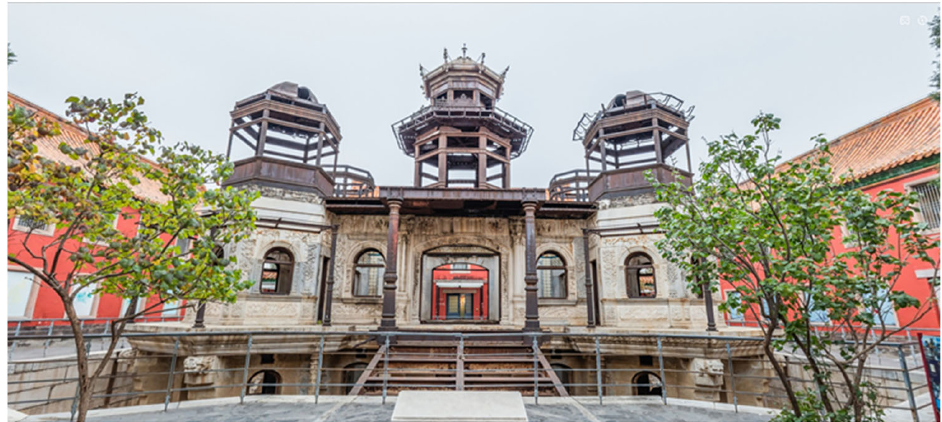
Figure 1. The photo of Lingzhao Xuan of the Forbidden City.